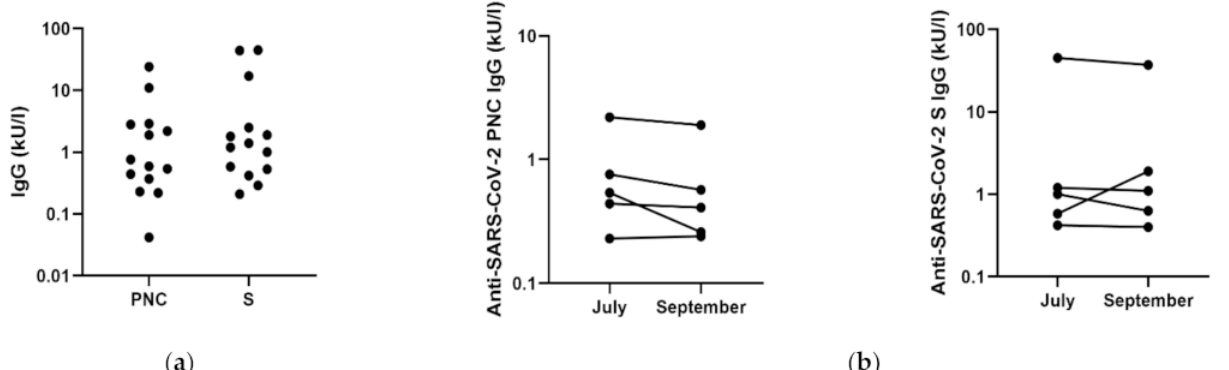
Figure 1. Anti-SARS-CoV-2 antibody levels among volunteers. ( a ) The total levels of anti-SARS-CoV-2 phosphorylated nucleoprotein (PNC) and anti-SARS-CoV-2 spike (S) antibodies among study participants ( N = 14). ( b ) The changes in the anti-SARS-CoV-2 PNC ( left ) and anti-SARS-CoV-2 S ( right ) antibody levels within 10 weeks in five study participants. Each dot represents a single study